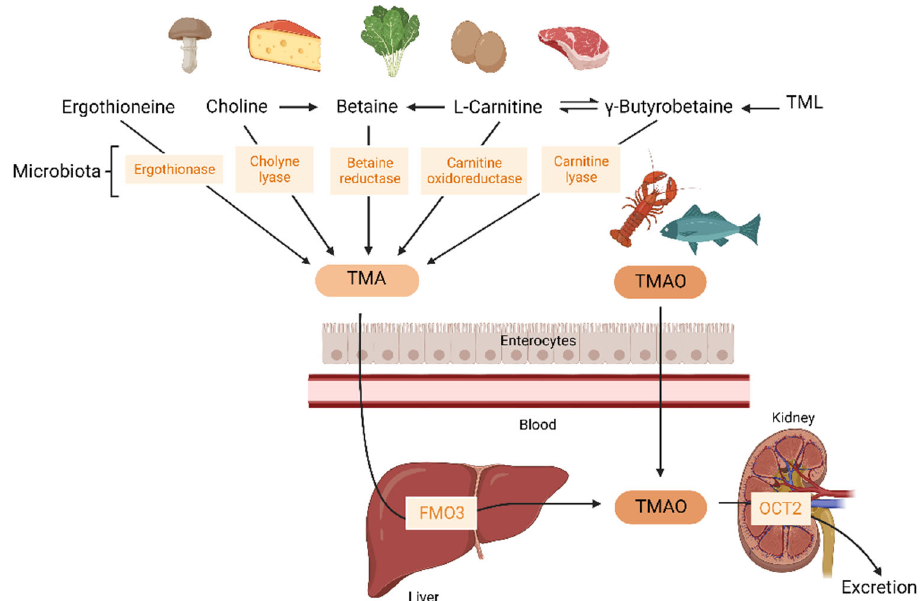
Figure 1. Schematic representation of TMA/TMAO formation and TMAO excretion. TMA is obtained from dietary precursors, such as ergothioneine, choline, betaine, L-carnitine, γ -butyrobetaine, and TML metabolized by microbial enzymes. TMA crosses the intestinal barrier and, in the liver, is converted into TMAO by FMO3. TMAO can be directly obtained from fish and marine invertebrates. It crosses the intestinal barrier and is mainly removed by renal excretion. TMAO could interact with endothelial cells in circulation during its metabolism, after oxidation in the liver, and before entering into the kidneys. The potential effects of circulating TMAO on atherogenic processes are shown in Figure 2. TMA: Trimethylamine-mine; TMAO: Trimethylamine-N-oxide; TML: Trimethyllysine; FMO3: flavin monooxygenase 3; OCT2: organic cation transporter 2. L-carnitine is synthesized endogenously from methionine and lysine in the